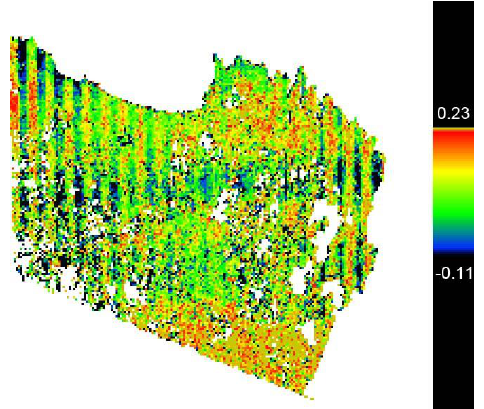
Figure 3. Systematic y-parallaxes WorldView-2, model 3 [m] The WorldView-2 models 2 and 4 of the area Karaburun,